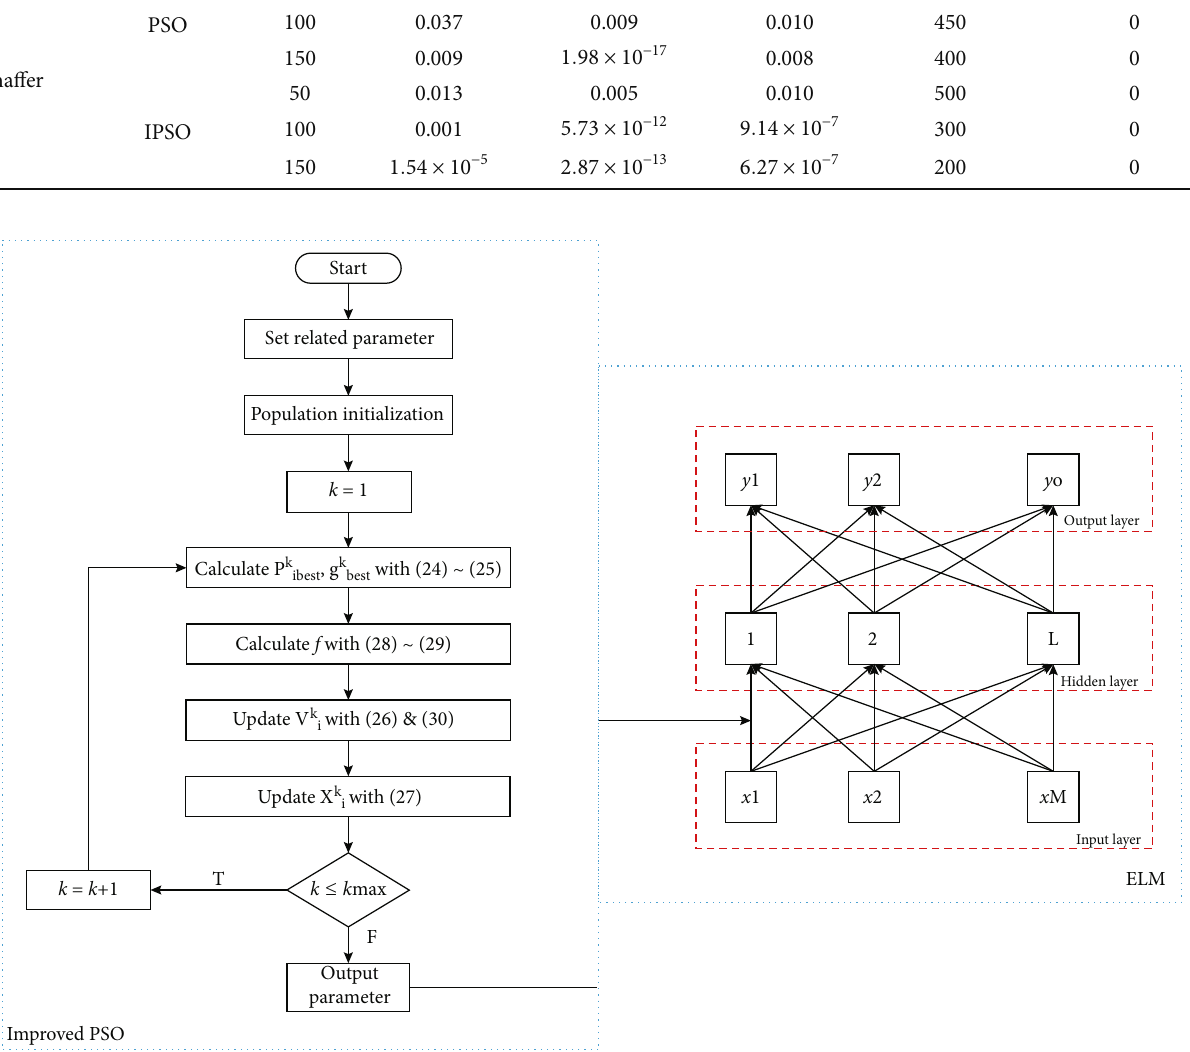
Figure 2: The structure of